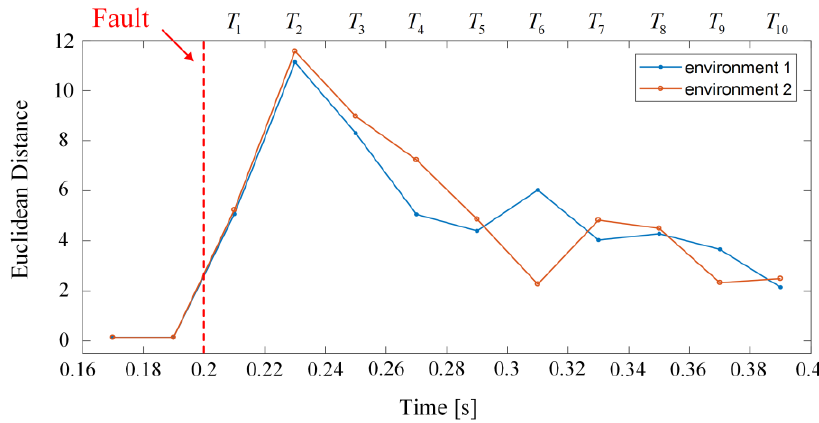
Figure 6. Euclidean distance over 10 periods for S 2 and S 3 open-circuit fault waveforms under two environmental conditions.